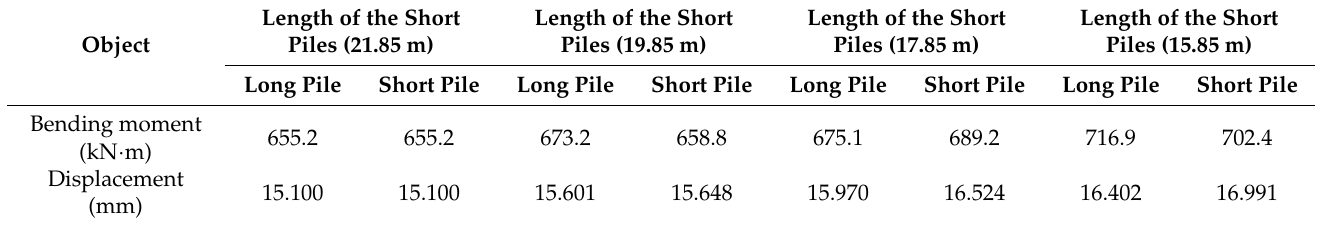
Figure 14. Layout form and the calculation result of combination 1: ( a ) The pile layout under the condition that the short pile length is 19.85 m; ( b ) the overall model displacement contour map. Table 4. Bending moment and displacement at control points of long-short piles corresponding to different short pile lengths (combination